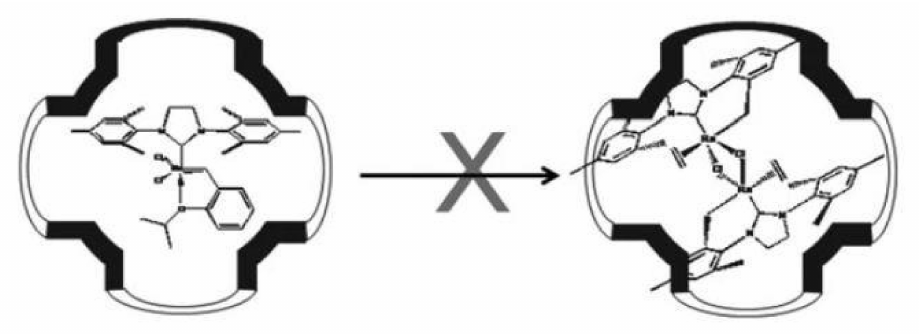
Figure 5. Proposed mechanism preventing dimerization of ruthenium complex in nanocages of SBA-1. Reprinted from Reference [67] with permission from The Royal Society of